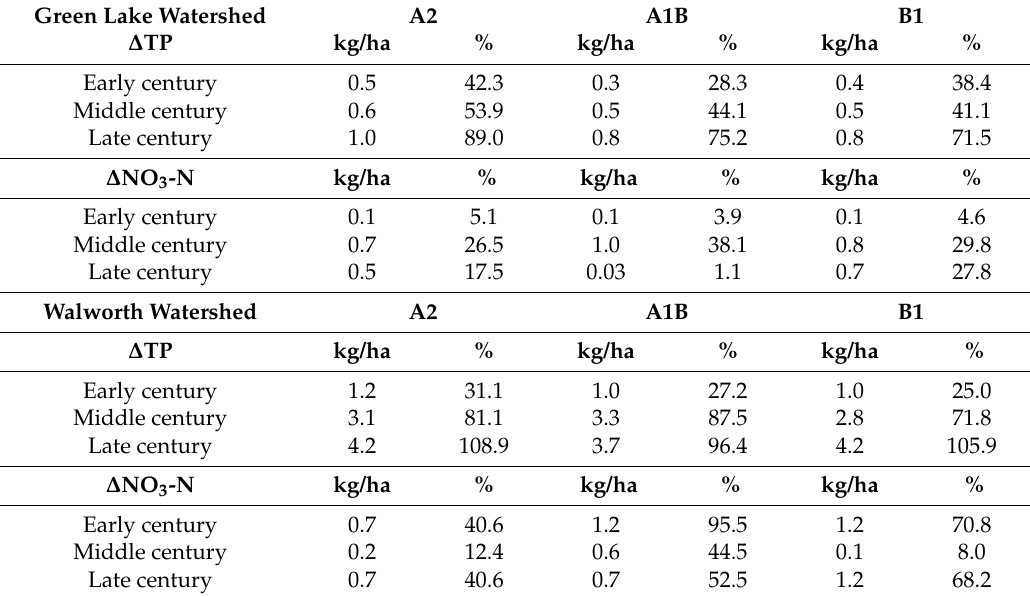
Table 7. Change percentage in annual total phosphorus and NO 3 -N losses relative to the base period for three future climate